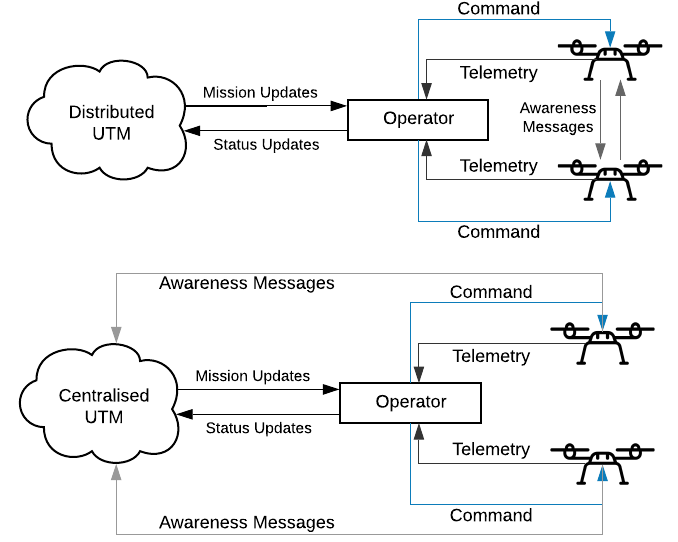
Figure 6. Communicated messages in a distributed and centralised UTM